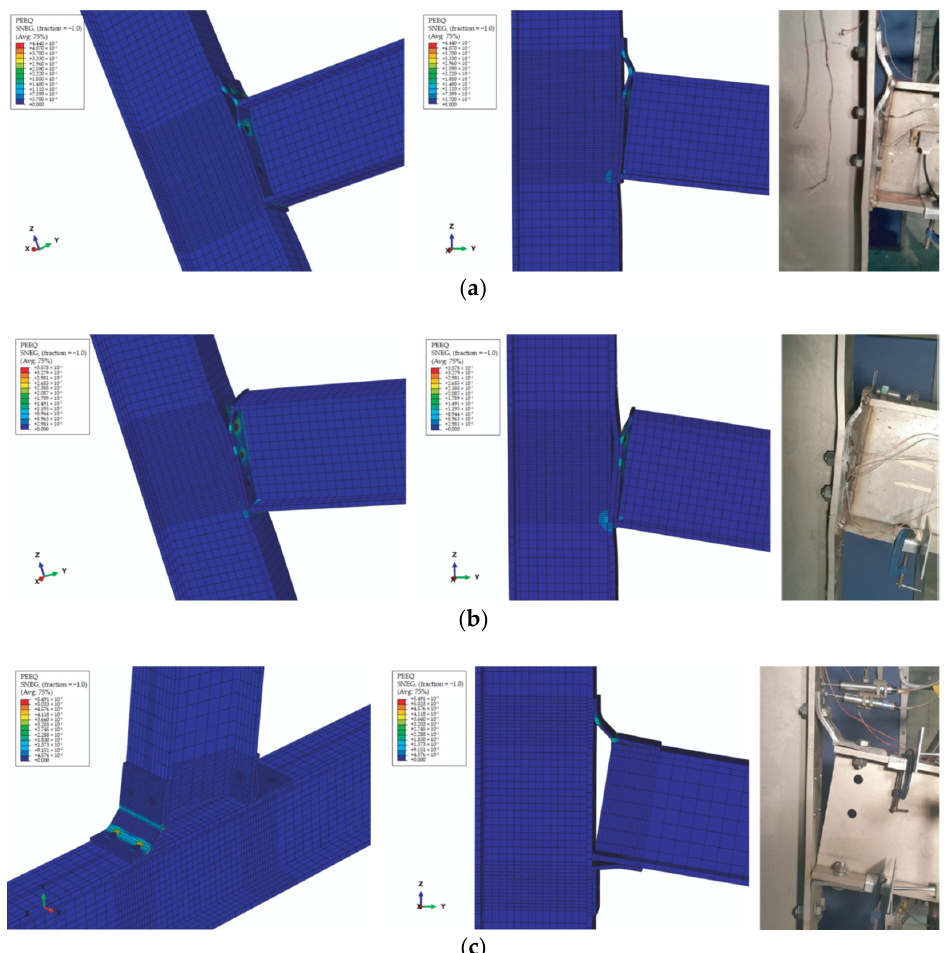
Figure 10. Comparison of numerical (left) and experimental (right, reprinted with permission from Ref. [29]) failure modes. ( a ) Extended End-Plate (EEP), ( b ) Flush End-Plate (FEP), ( c ) Top-and-Seat Angle Cleat connection (TSAC).